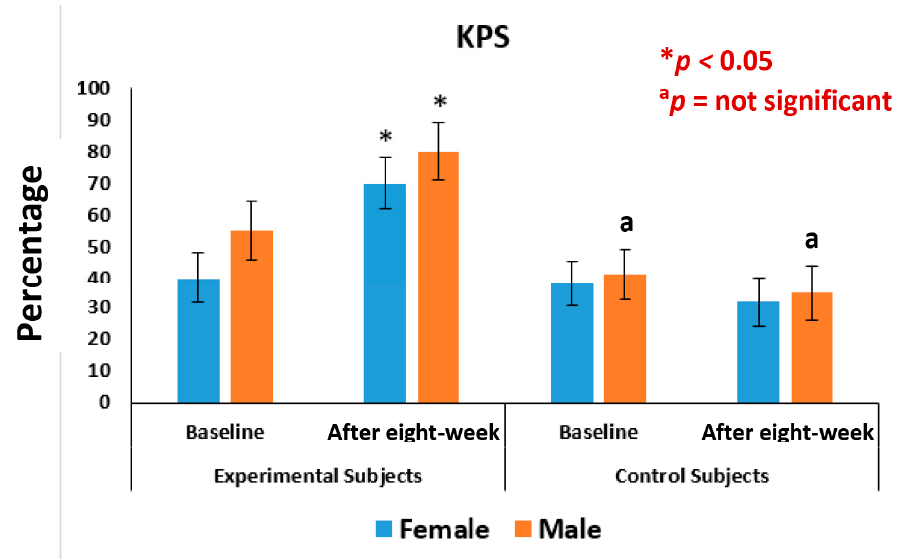
Figure 9. Analysis of knee-injury osteoarthritis outcome scale of 45 control subjects, female ( n = 27) and male ( n = 18), before and after eight-week without supplement ( ᵃ p = not significant), ADL: Activities of daily living ; QOL: Quality of life.